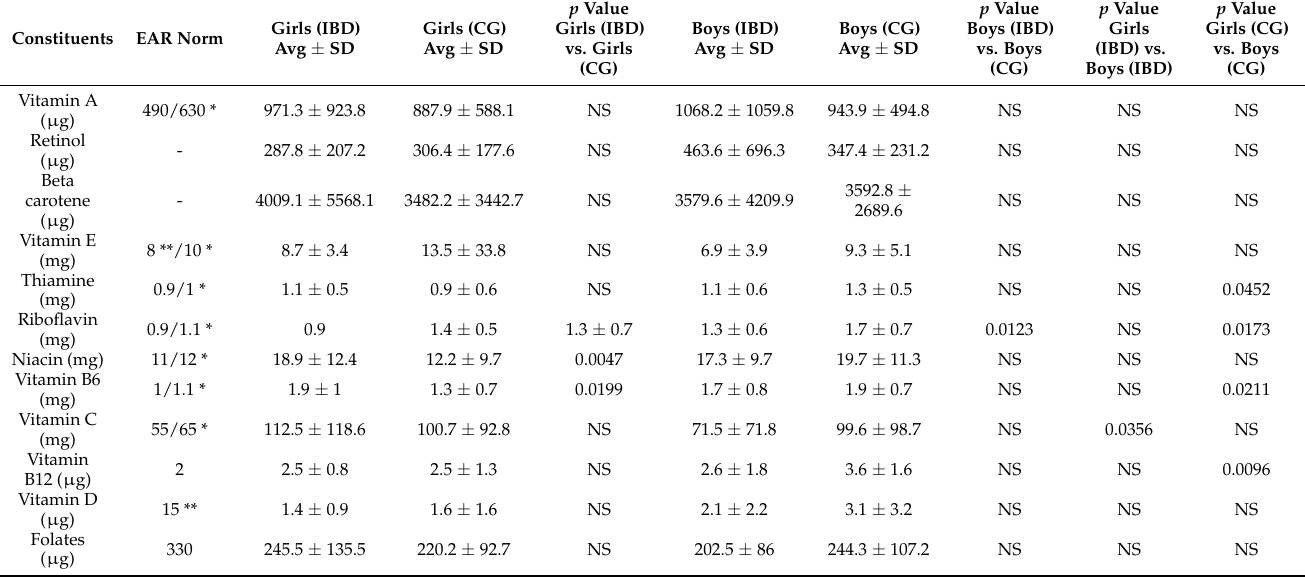
Table 3. A comparison of vitamin